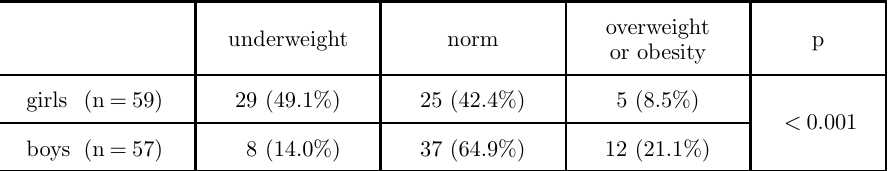
overweight or obesity